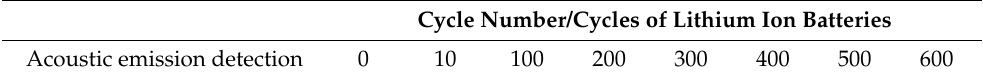
Table 2. Signal acquisition